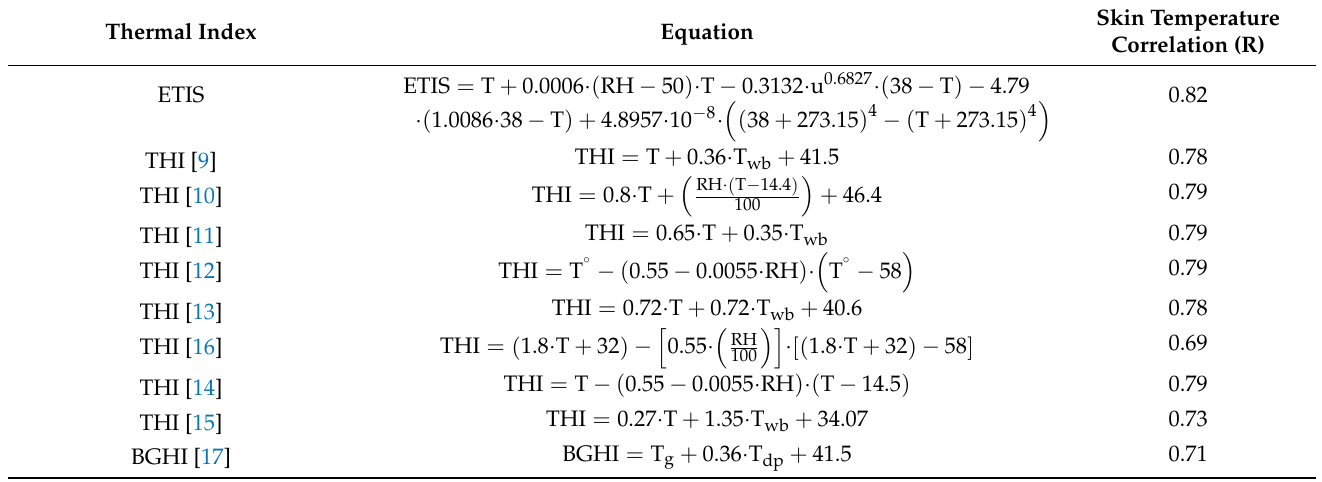
Table 3. Pearson correlation coefficient between the thermal index and physiological responses (skin temperature) (all p -values < 0.0001). The thermal index and the skin temperature are positively correlated. When the Pearson correlation coefficient R is closer to 1, the correlation is